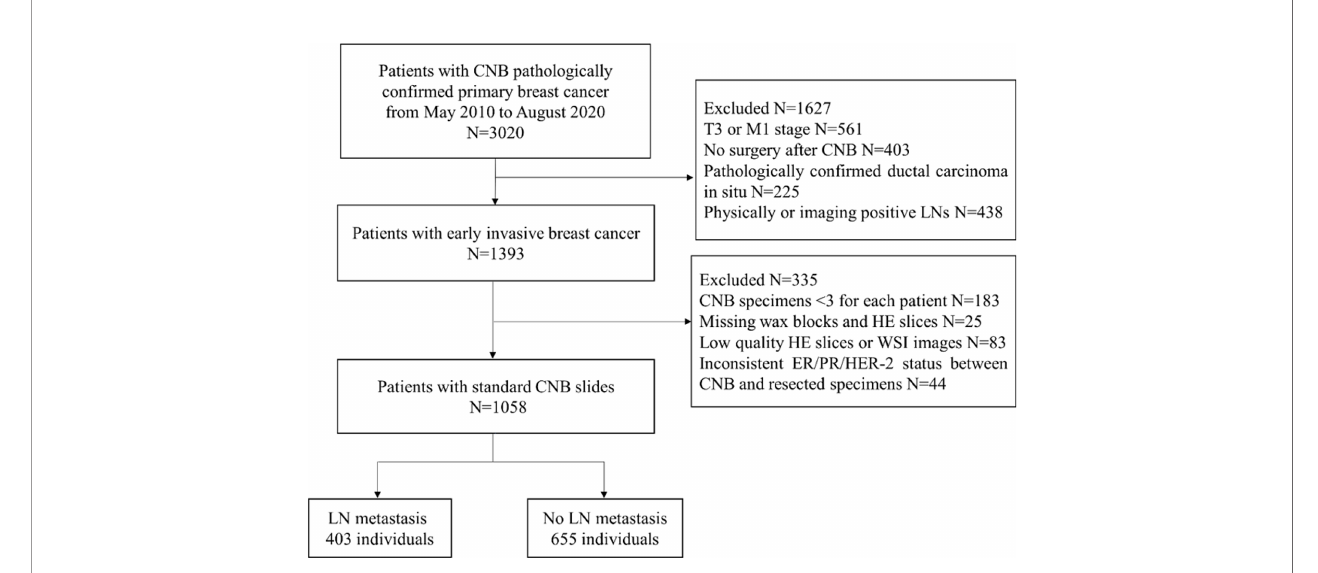
FIGURE 1 | Patient recruitment work fl